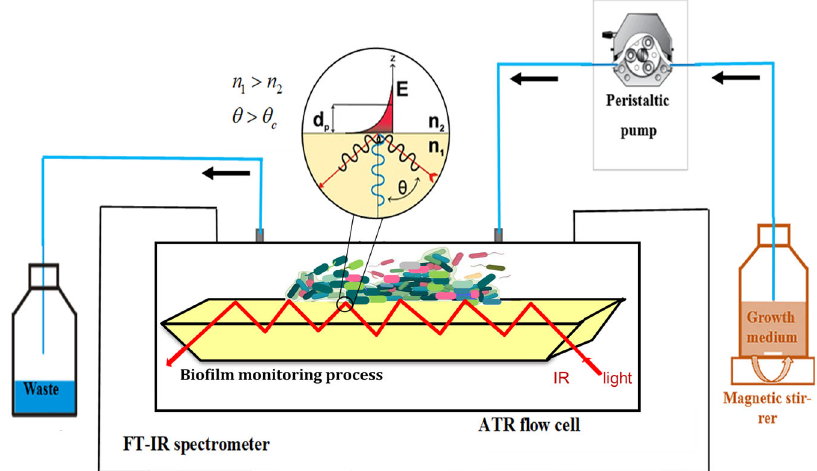
Fig. 11 Custom IR-ATR fl ow cell concept. The continuous fl ow assembly was equipped with a ZnSe ATR waveguide providing 6 internal re fl ections for monitoring bio fi lm formation and evolution via evanescent fi eld absorption